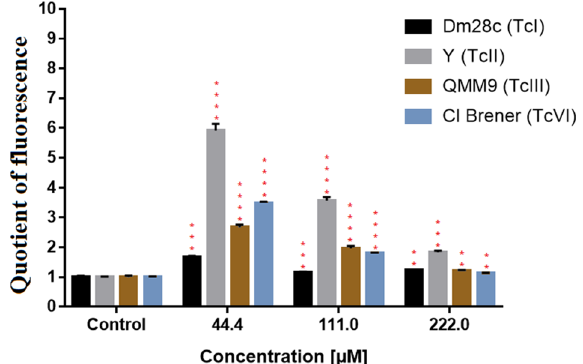
Figure 6. Evaluation of reactive oxygen species production in trypomastigote forms of T. cruzi after 24 h of exposure at DETC. The different strains of T. cruzi were treated with 4 concentrations of DETC (22.2 µM, 44.4 µM, 111.00 µM and 222.00 µM. Results presented as mean ± standard deviation of the percentage of parasitic inhibition in a triplicate system and for the statistical analysis the Anova Test together with the Tukey Post-test P < 0.0001(****) when compared with control. Software GraphPad Prism v. 7.0 (2016) (https:// www. graph pad.